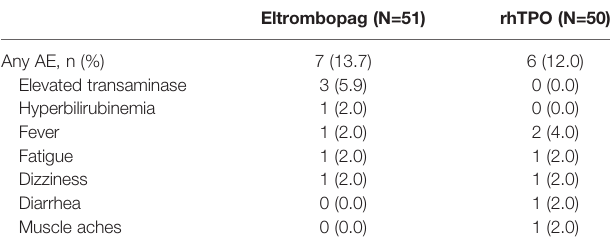
TABLE 5 | Treatment-related adverse